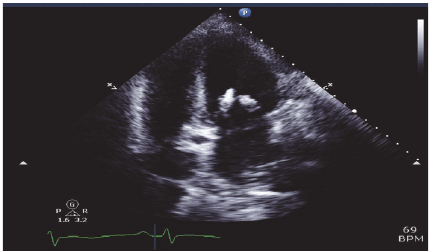
Figure 3: Image depicting a transthoracic echo cardiogram, depict- ing vegetation and severe mitral regurgitation.